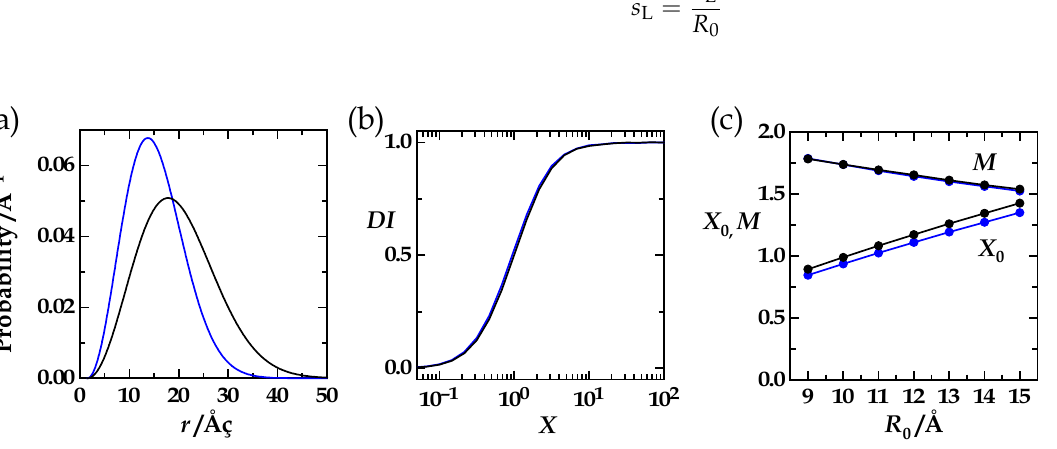
Figure 6. The HSE was solved for two different series of ideal-chain distributions (Equation (18)). R 0 was varied from 9Å to 15Å, and r L was varied from 1.5Å to 5Å. The donor lifetime was held constant ( 𝜏 D = 100 ns). In one series of distributions, the constant b was chosen as b = 1.5 ⋅ R 0 ranging from 13.5Å to 22.5Å, in the other series as b = 2 ⋅ R 0 ranging from 18Å to 30Å. ( a ) Exemplary distributions for the two series with r L = 3Å, R 0 = 10Å and either b = 1.5 ⋅ R 0 = 15Å (blue curve) or b = 2 ⋅ R 0 = 20Å (black curve). ( b ) The DI ( X ) profiles overlap for both distributions shown in ( a ). ( c ) All DI ( X) profiles were analyzed by using Equation (13).